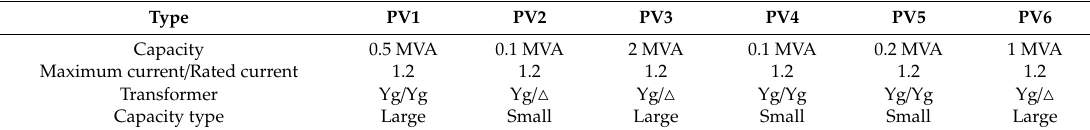
Table 3. Set values for photovoltaics